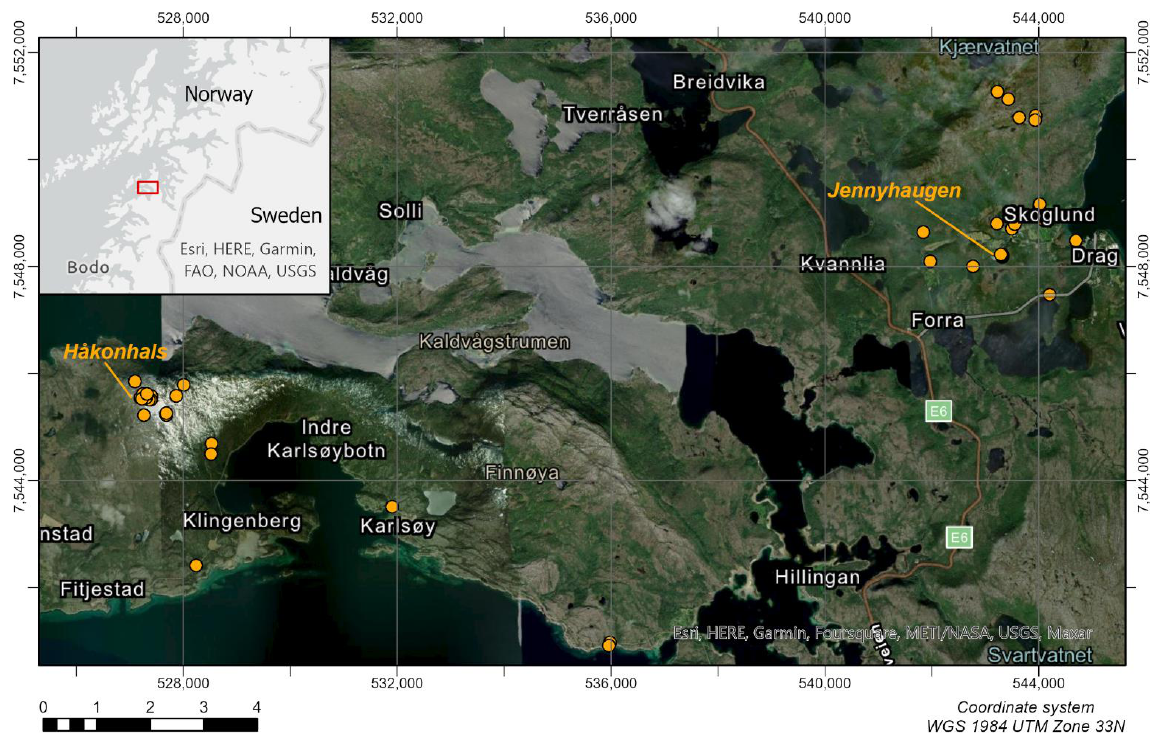
Figure 5. The Tysfjord area in Norway with the locations of the samples for the petrophysical database indicated by orange dots. The dot cluster in the west is at the Håkonhals mine. The cluster in the east is at the Jennyhaugen mine and pegmatite occurrences in the surroundings. The red frame in the inset map outlines the location map.